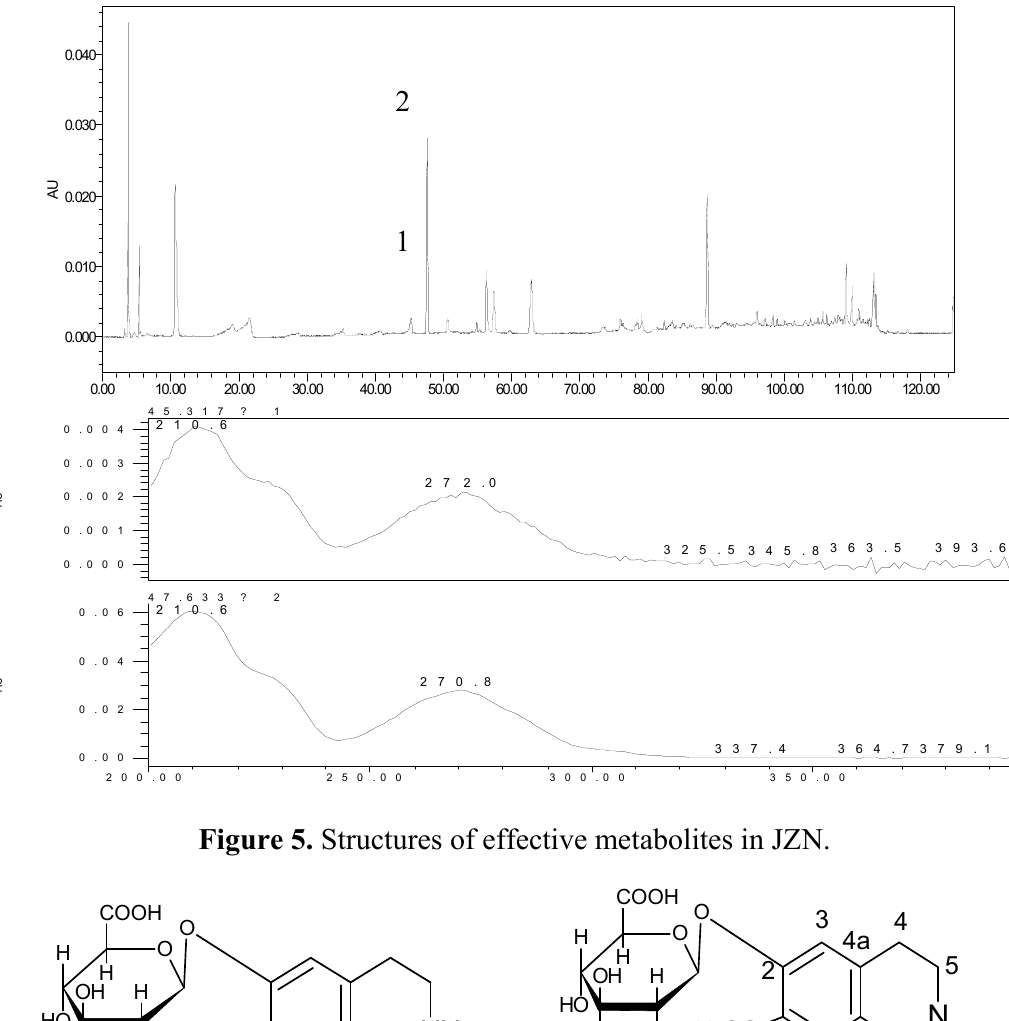
Figure 4. HPLC and UV spectra of the plasma sample after the intragastric administration of 2-hydroxy-1-methoxyaporphine.